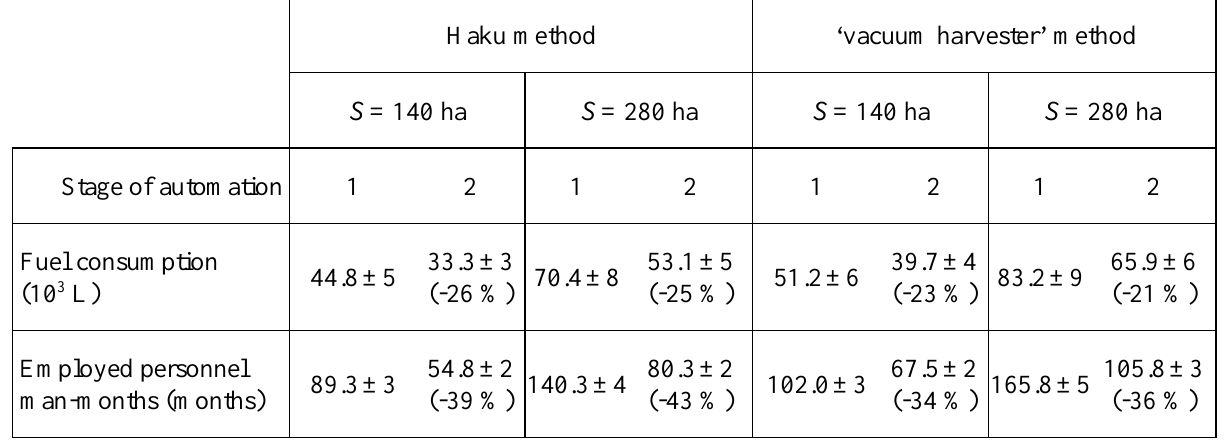
Table 2. Volumetric fuel consumption of haulage machinery and man-months’ employment required to operate peat fields with surface areas ( S ) of 140 and 280 ha by the Haku method and the ‘vacuum harvester’ method for the duration of one extraction season, at Stage 1 and Stage 2 of automation (see Figure 1). For Stage 2, the values in parentheses indicate the percentage change effected by using centrally controlled UGVs (instead of conventional tractors) to haul milling and harrowing implements (only), where they can replace tractors one- for-one (see Table